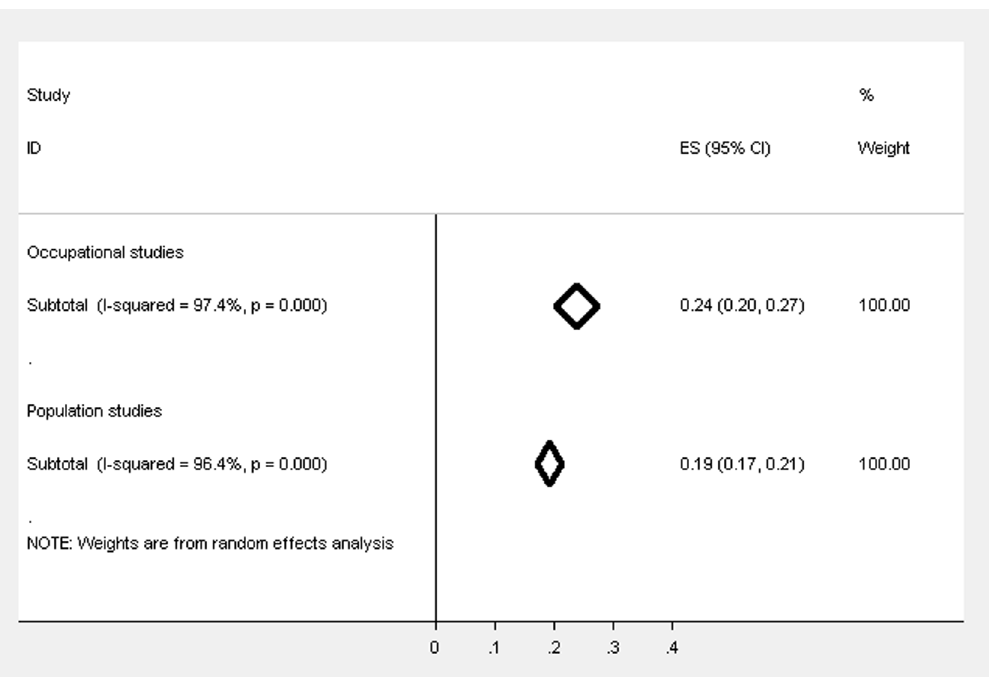
Figure 6. Forest plot displaying the weighted estimates for CMD caseness between the occupational and population studies (restricted to studies using GHQ-12 (3/4), response rate $ 50% & random sampling).